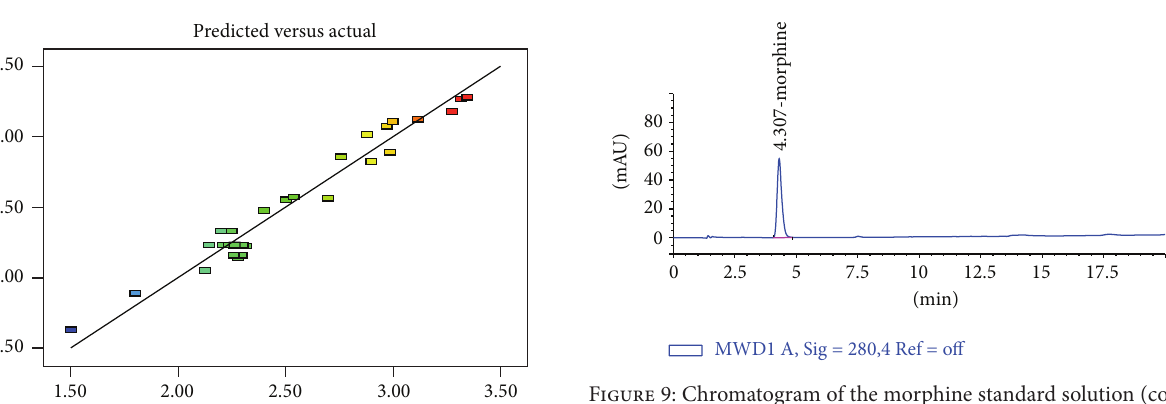
Figure 9: Chromatogram of the morphine standard solution (con- centration: 200 𝜇